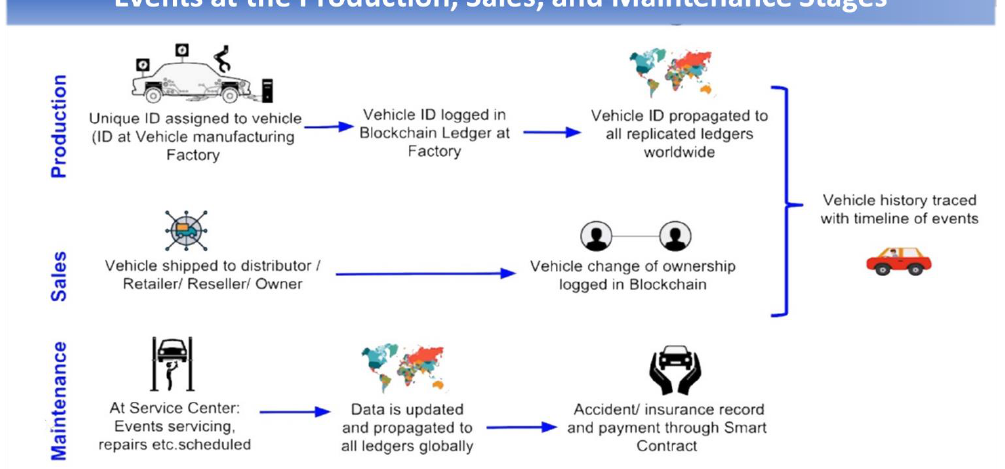
Figure 6. Events (to be saved in the blockchain) at the various stages of the automotive lifecycle.